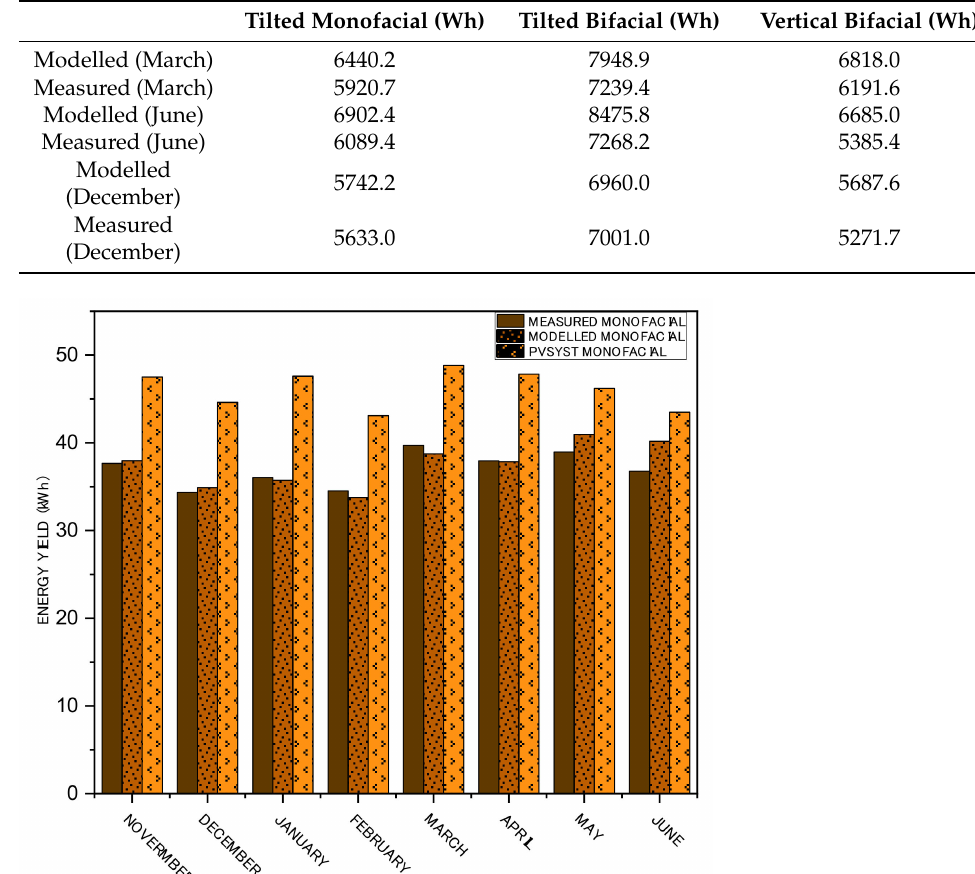
Table 4. Single-day in-plane radiation.